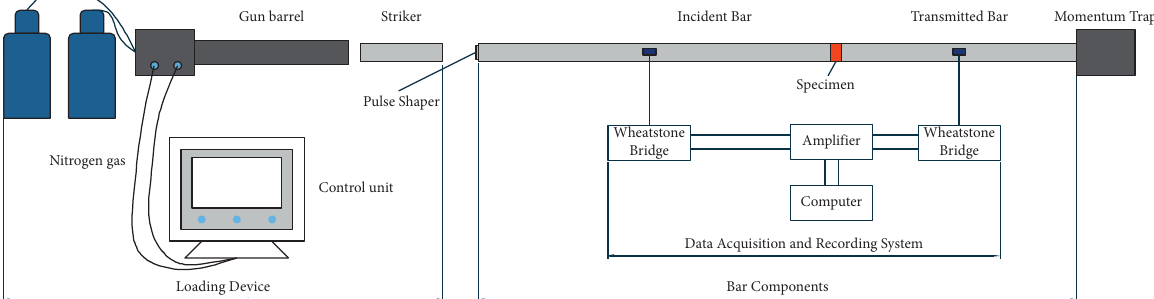
Figure 1: Schematic diagram of SHPB